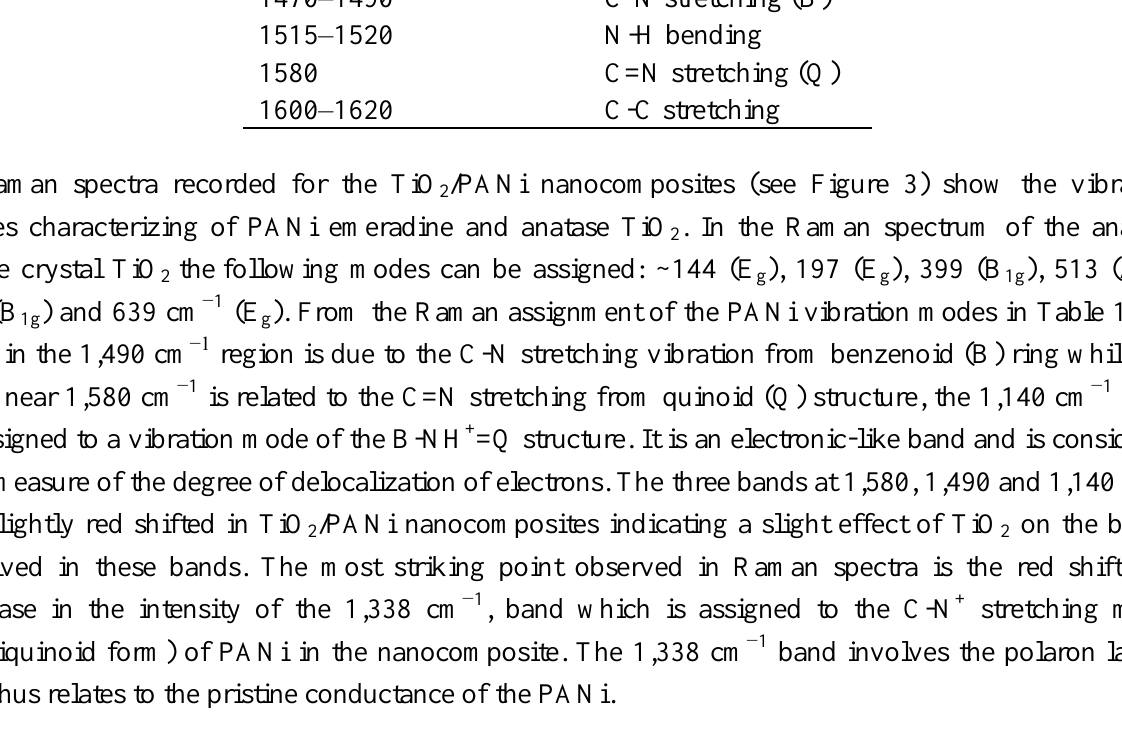
Figure 3. Raman spectra of PANi and TiO